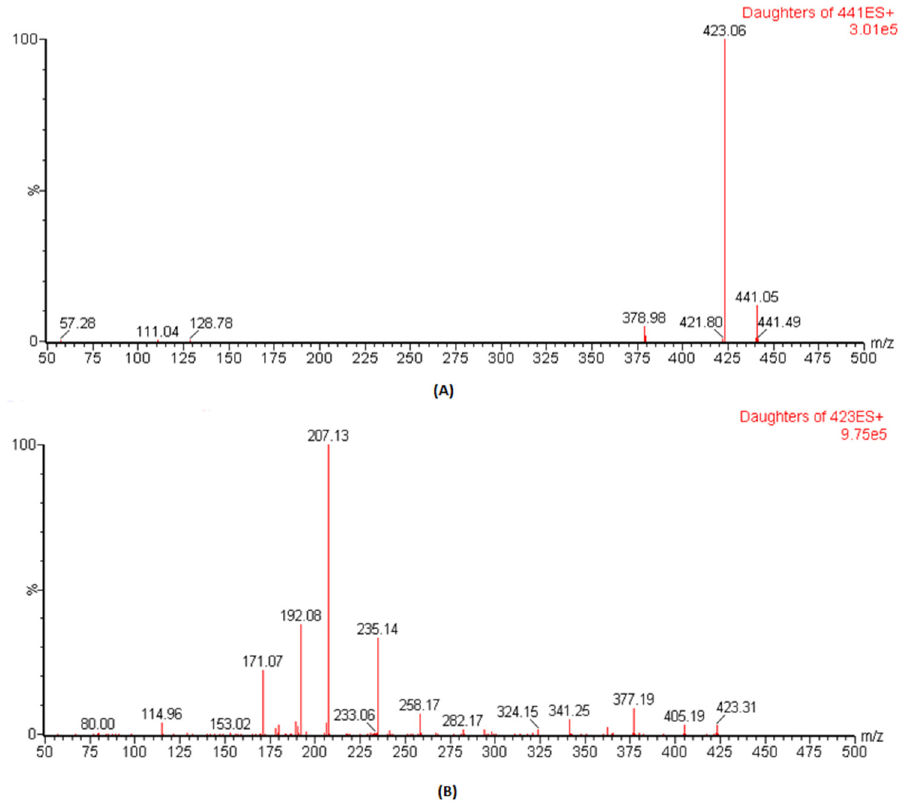
Figure 1. Spectrum representation for precursor to product ion transition of DFX ( A ) and IS ( B ).